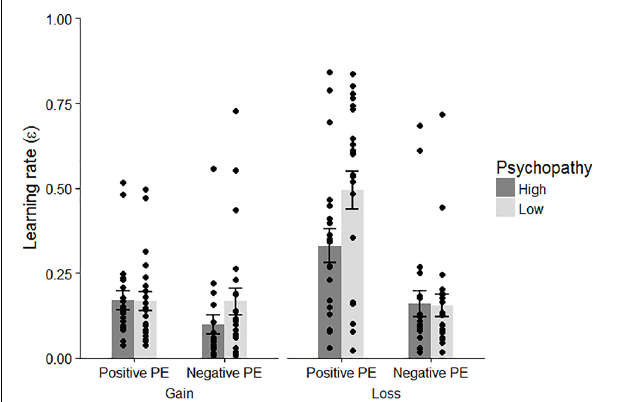
FIGURE 4 | Learning rates for each condition in the psychopathic and non-psychopathic groups. Error bars and dots represent standard errors and individual data, respectively.